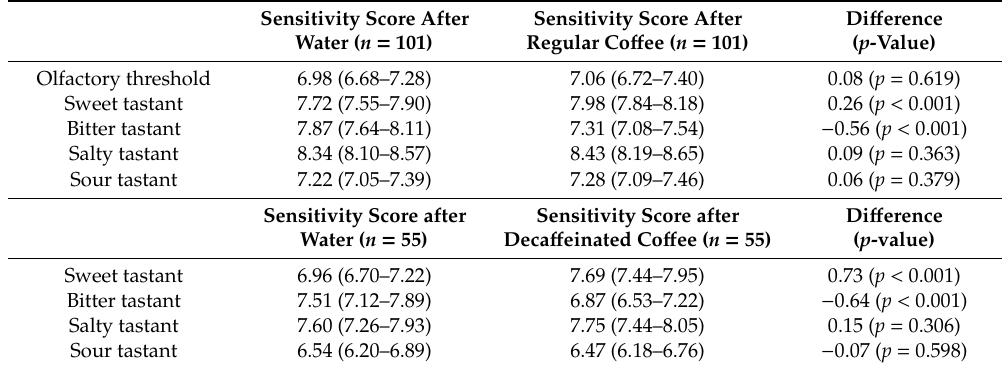
Table 2. Mean olfactory and gustatory scores before and after regular / deca ff einated co ff ee consumption. 95% confidence interval in